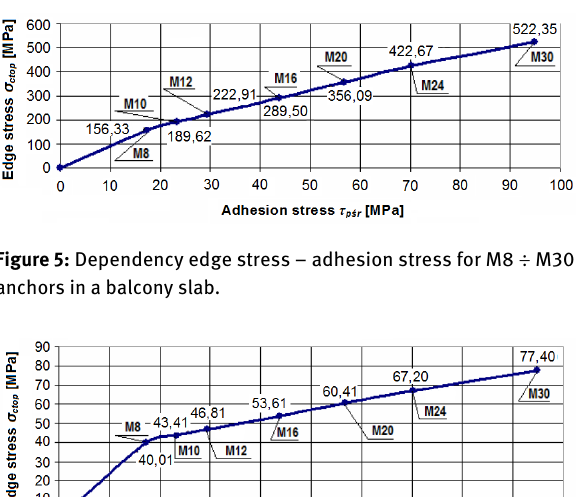
Figure 4: Dependency edge stress – adhesion stress for M8 ÷ M30 anchors in slab long under-window.